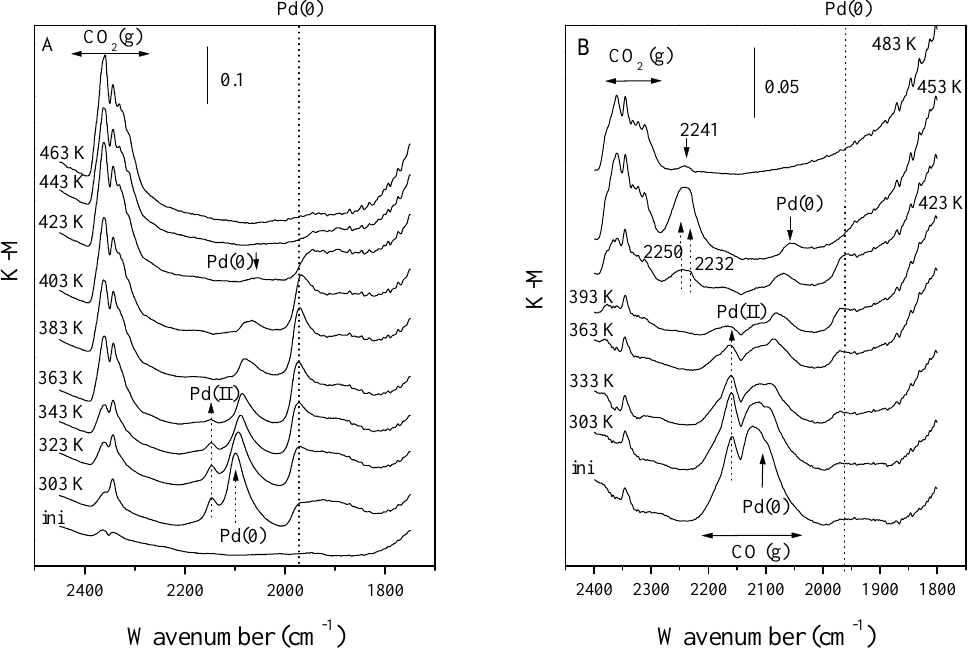
, and B) CO+NO+O , at in- 2 2